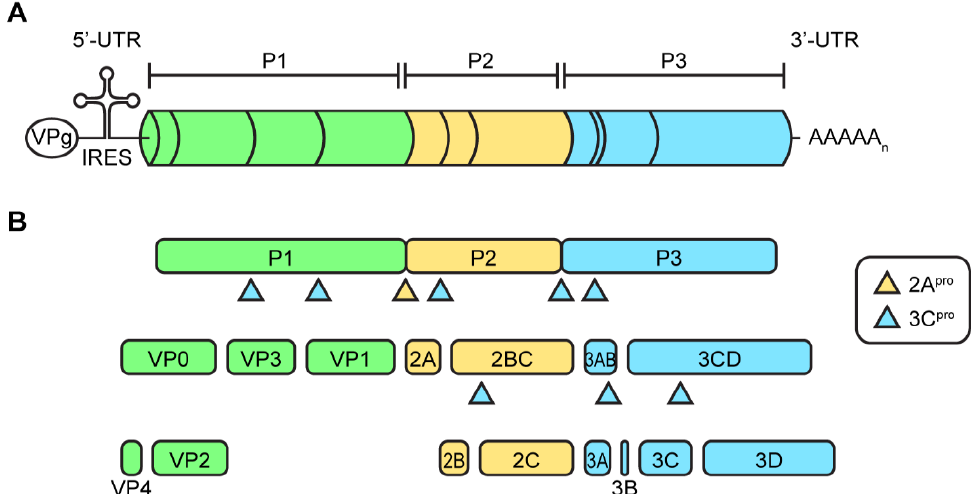
Figure 2. Enterovirus genome. ( A ) Depicted is a schematic representation of the enterovirus genome on scale. The enterovirus genome encodes a single polyprotein divided into a P1, P2, and P3 area. At the 5′- and 3′-end the genome contains untranslated regions (UTR), which are highly structured. The 5′-UTR contains an internal ribosomal entry site for cap-independent translation. At the 5′-end, the RNA genome is covalently bound to the viral protein VPg which is used as a primer during RNA replication; ( B ) The polyprotein is processed into the viral proteins and some stable precursors by the viral proteases 2A pro and 3C pro (and its precursors).